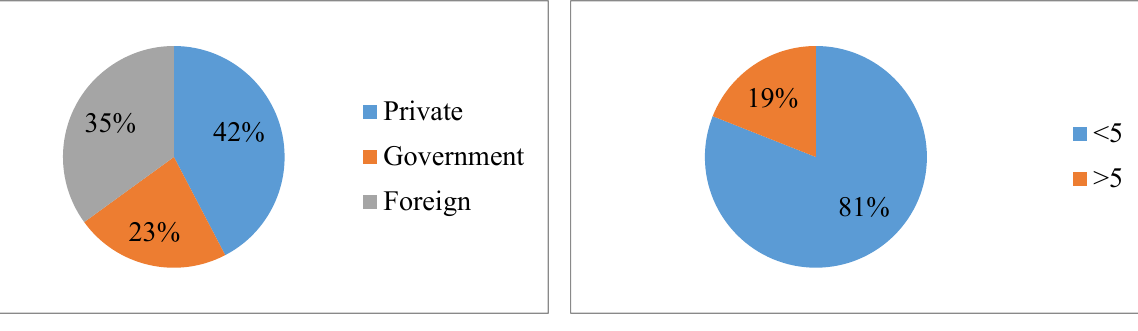
Fig. 3. Percentage of kind of company joining survey Fig. 4. How many tours your company organizes in one year?